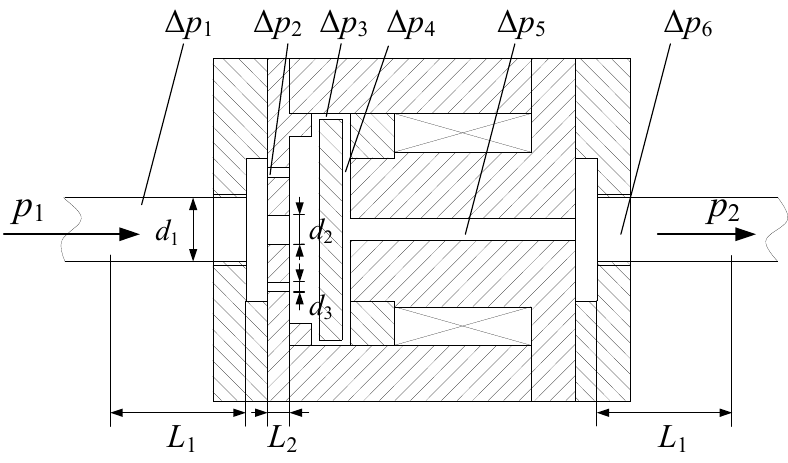
Figure 3. Pressure drop distribution of the proposed MR valve.